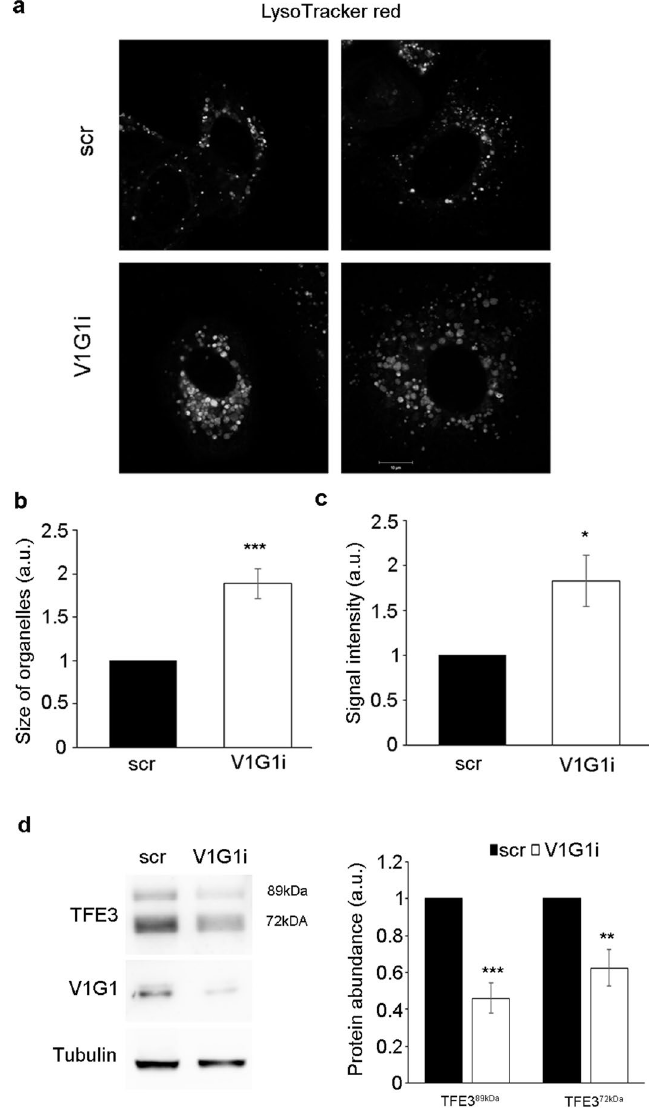
Figure 6. V1G1 modulates late endocytic compartments in MCF7 cells. ( a ) V1G1-depleted MCF7 cells (V1G1i) were labeled with Lysotracker Red and analyzed by confocal microscopy, scale bar: 10 µm. ( b ) The size of organelles was quantified by ImageJ software. Data represent the mean ± s.e.m. (at least 4 independent experiments, ≥ 15 cells /sample for each experiment) *** p ≤ 0.001. ( c ) Lysotracker Red intensity was quantified by ImageJ software and Corrected Total Cell Fluorescence was calculated. Data represent the mean ± s.e.m. (at least 4 independent experiments, ≥ 15 cells/sample for each experiment) * p ≤ 0.01. ( d ) Relative protein abundance of the two active isoforms of TFE3 and V1G1 was assessed by western blotting, quantified by densitometry and normalizing against tubulin. Data represent the mean ± s.e.m of at least three independent experiments (* p ≤ 0.01, ** p ≤ 0.01, *** p ≤